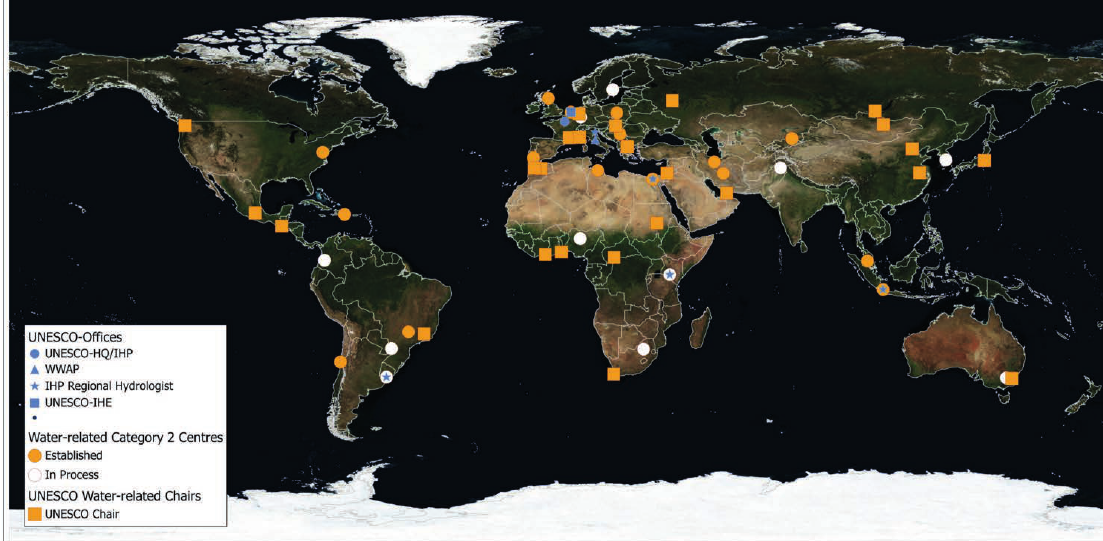
Fig. 3 The map of UNESCO’s Water Family’s worldwide network (six additional centres have been proposed and established since early